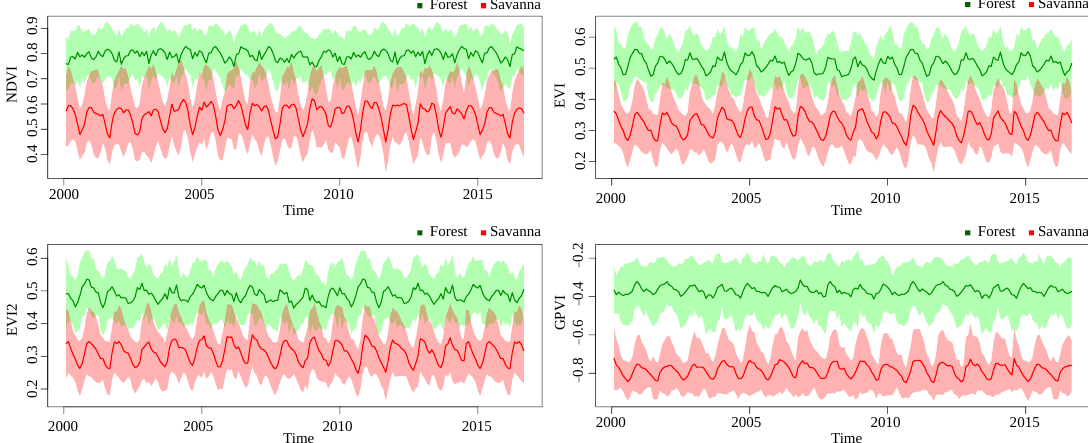
Figure 9. Time series for forest/savanna discrimination (MODIS). Shaded areas indicate the standard deviation of the index scores among all of the data points for a given timestamp.